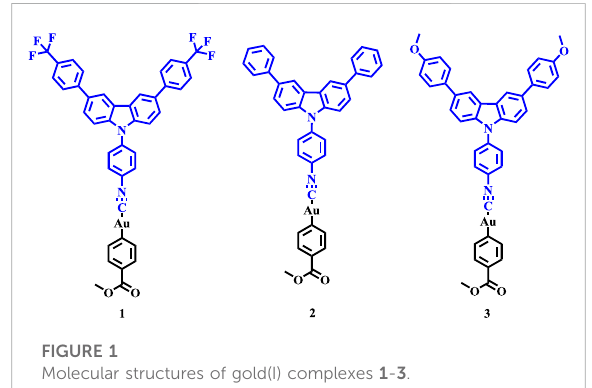
FIGURE 1 Molecular structures of gold(I) complexes 1 - 3